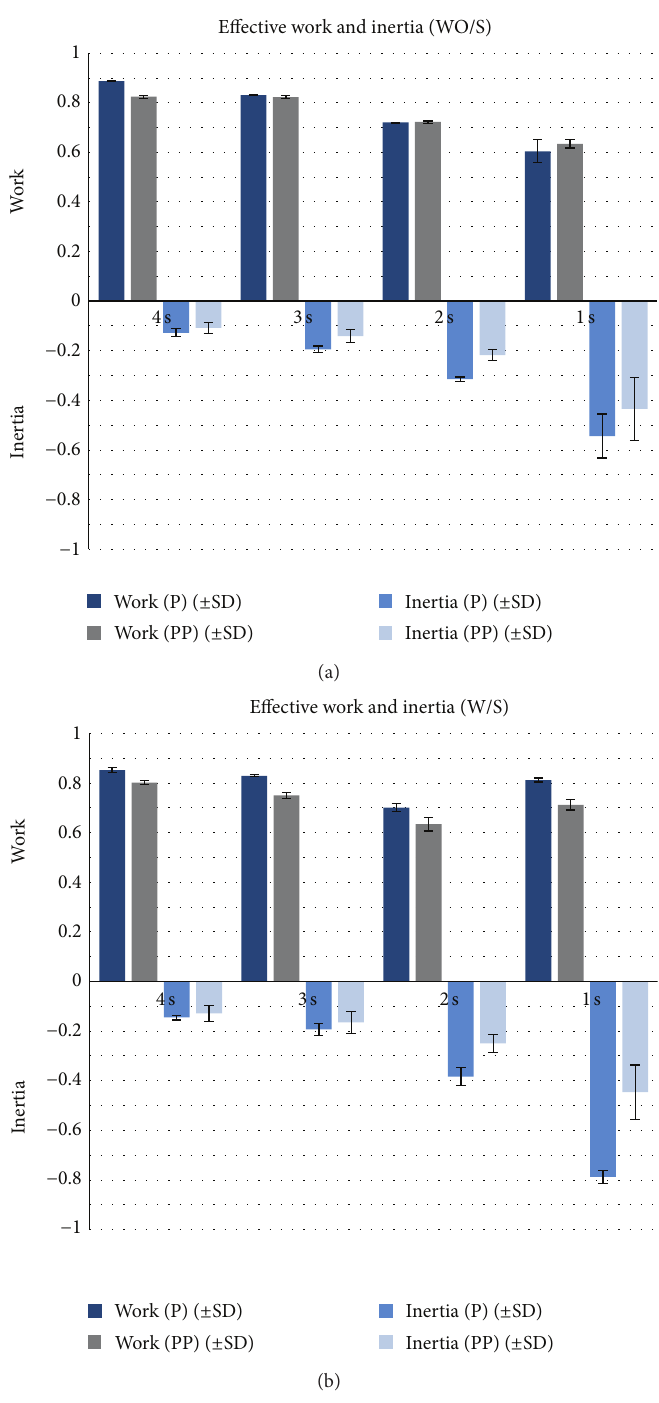
Figure 14: Effective work and inertia for the control of leg orthosis for both WO/S and W/S tests using cocontraction model based P and PP